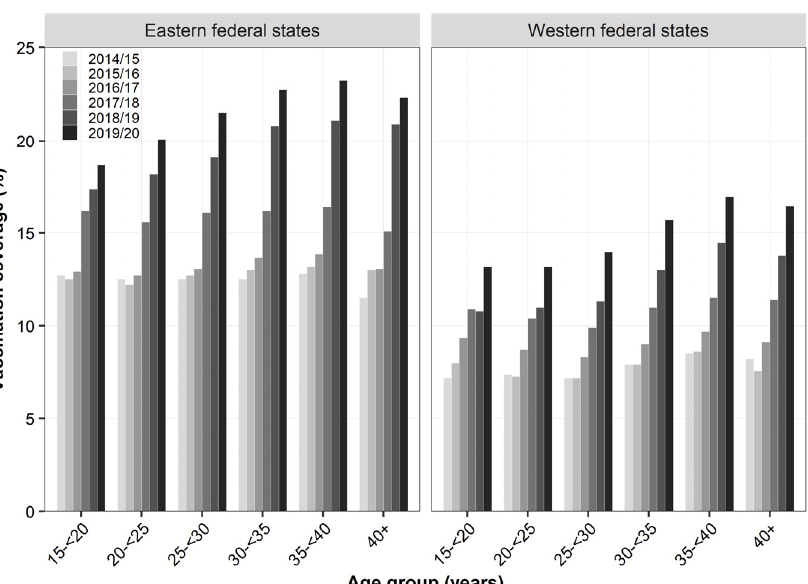
Figure 1. Influenza vaccination coverage (%) during pregnancy across region and age group based on outpatient claims data, seasons 2014/15 to 2019/20.